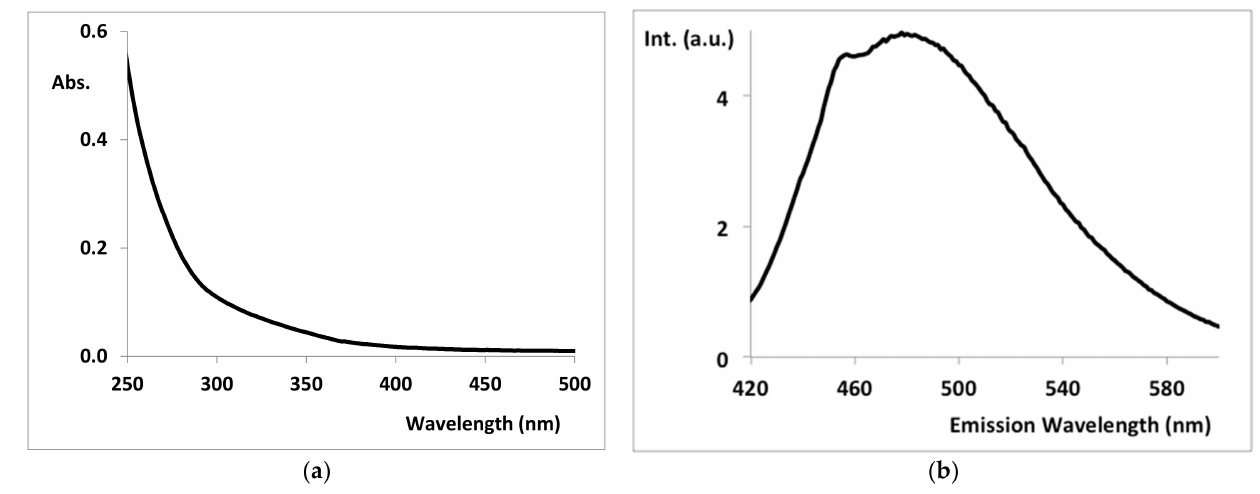
Figure 5. ( a ) UV-Vis and ( b ) fluorescence emission (ex. 350 nm) spectra of